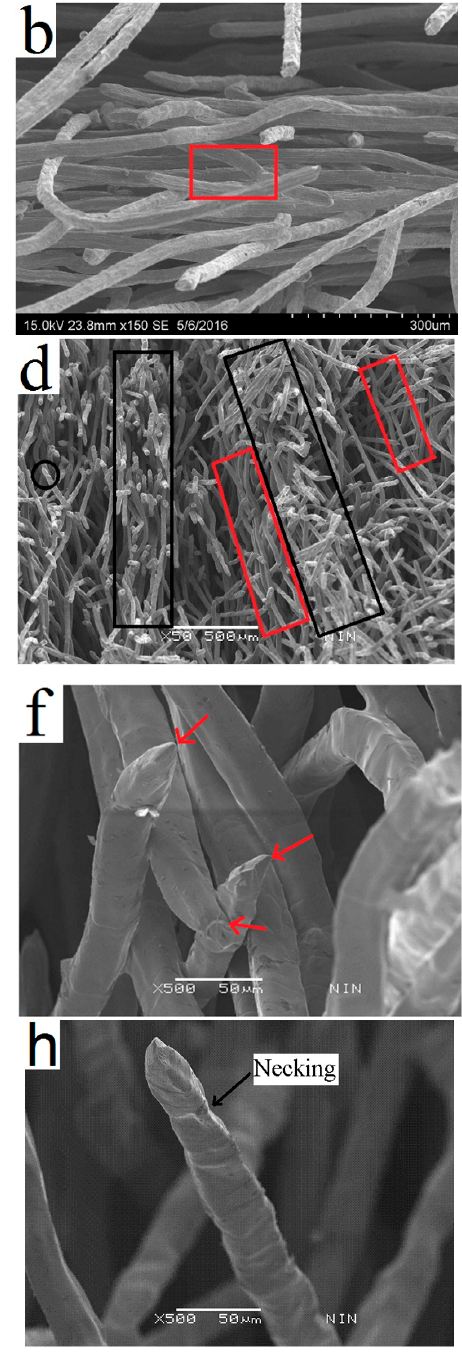
Figure 10. Fracture surfaces of tensile samples of 316L SSFFs ( a ) I, area of two kinds fractures; ( b ) I, enlarged area of delamination in ( a ); ( c ) I, enlarged area in the red box in ( b ); ( d ) VI, area of two kinds fractures; ( e ) VI, enlarged area of delamination in ( d ); ( f ) VI, enlarged area in the red box in ( e ); ( g ) I, joint breakage at area of delamination; ( h ) VI, fiber breakage subjected to normal stress, enlarged area in the black circle in ( d ).